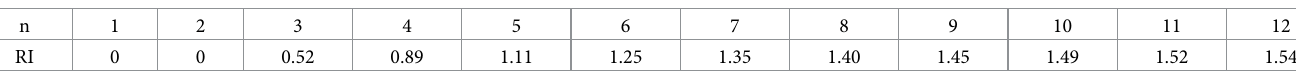
Table 3. Random index values depend on the matrix eigenvalue